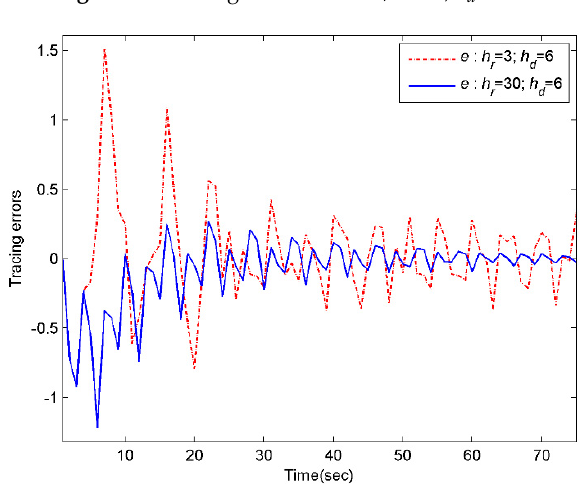
Figure 3. Tracking error curves under the same h d and di ff erent h r